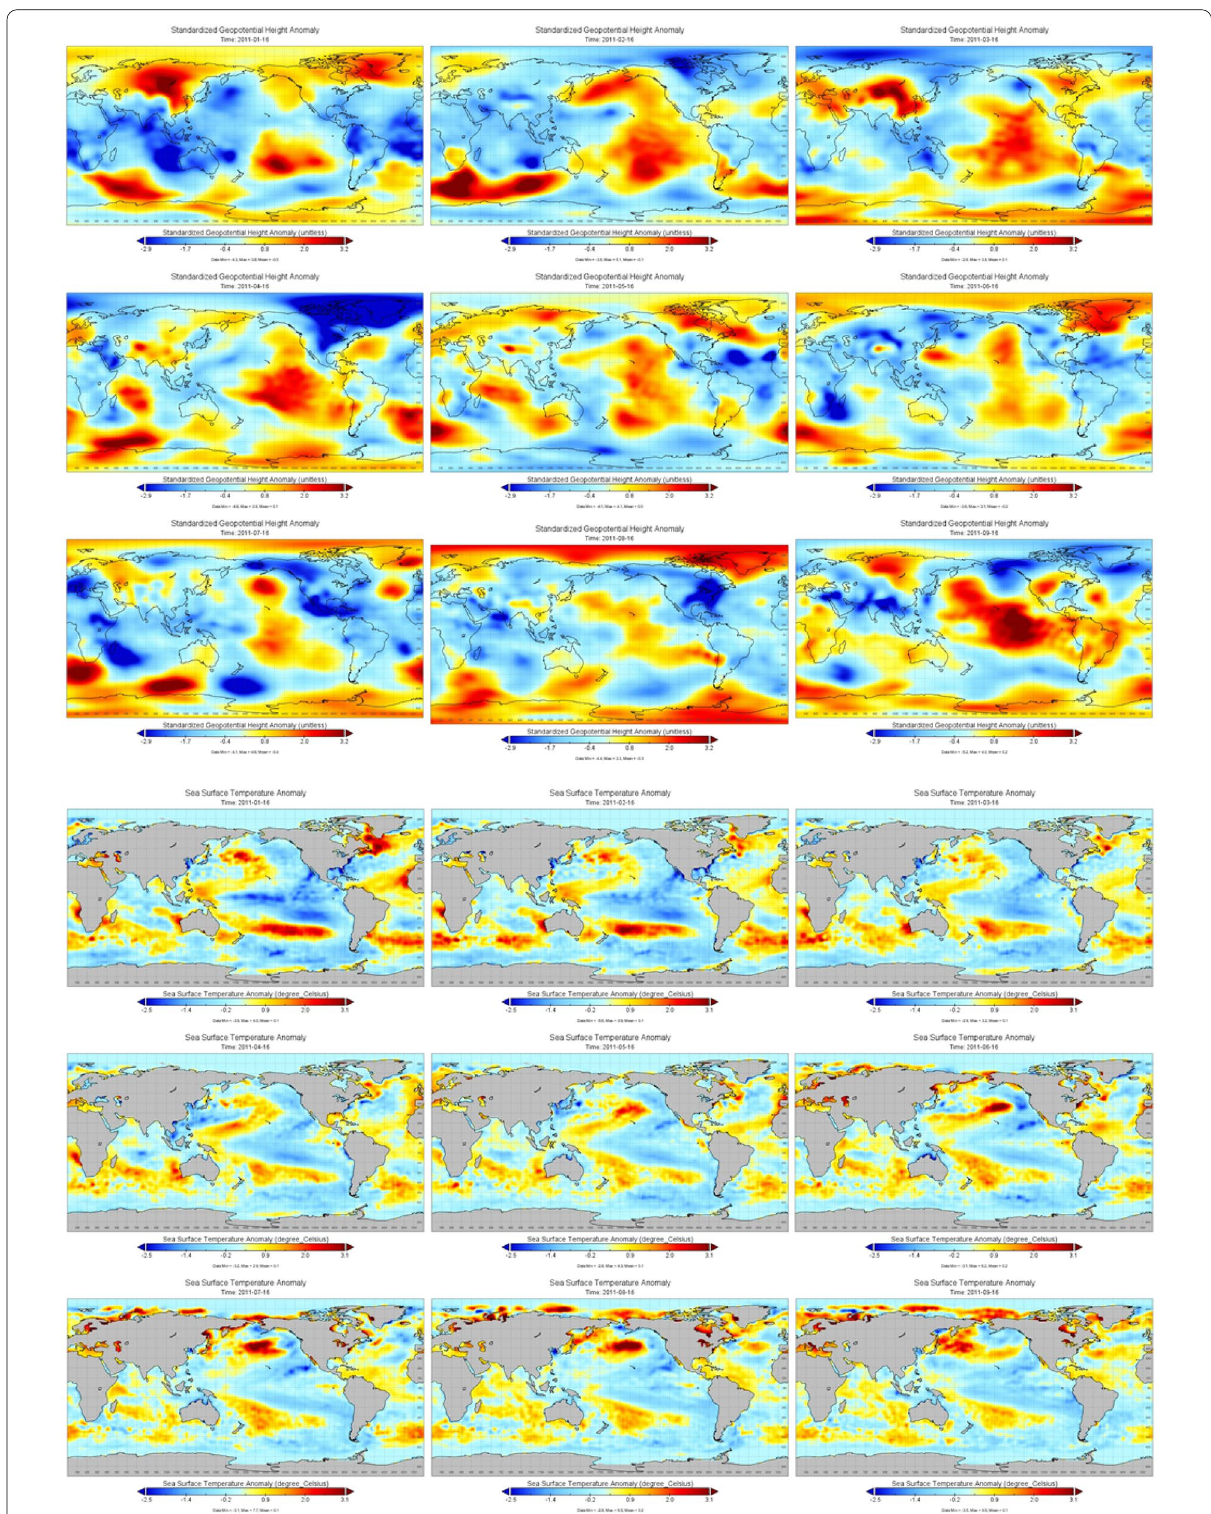
Fig. 19 Global-scale GPH and SST anomaly (January to September